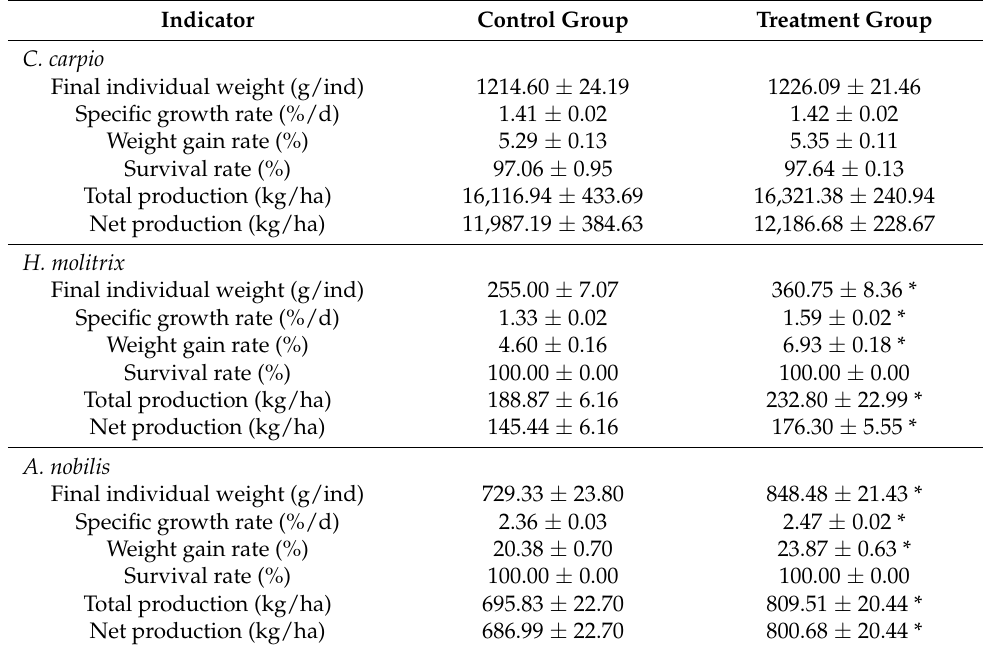
Table 2. Growth performance of C. carpio , H. molitrix and A. nobilis in different groups.